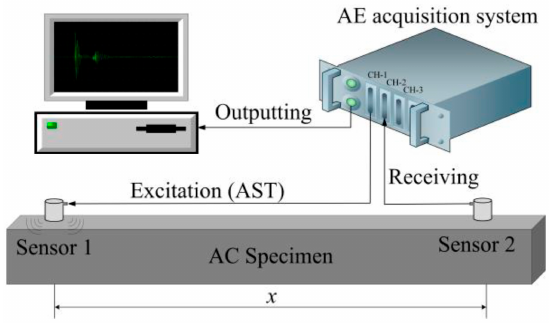
Figure 5. Measurement of the wave velocity by the AST method.